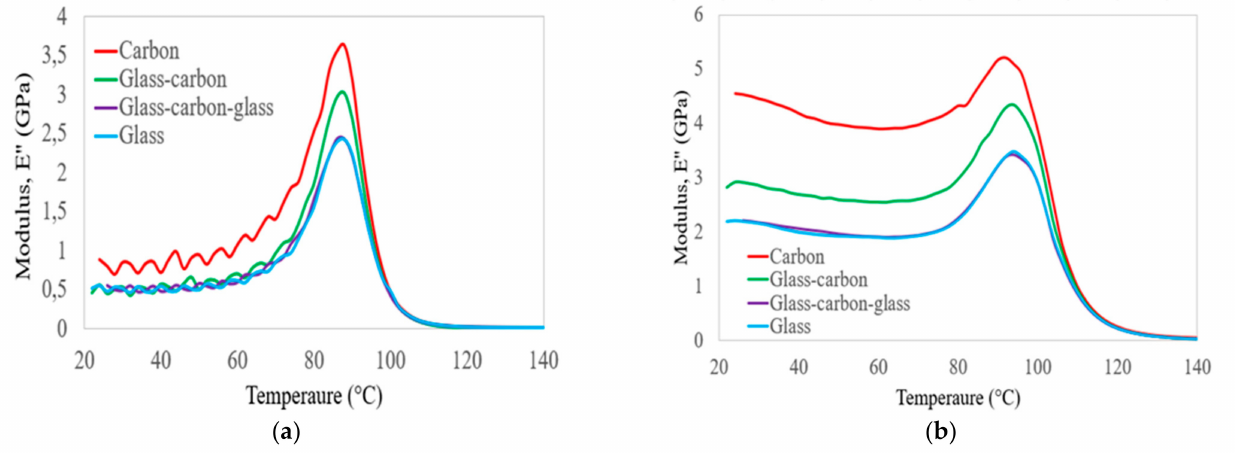
Figure 6. Comparison of the values of loss modulus on hybrid and non-hybrid bidirectional laminates at frequencies of ( a ) 1 Hz and ( b ) 100